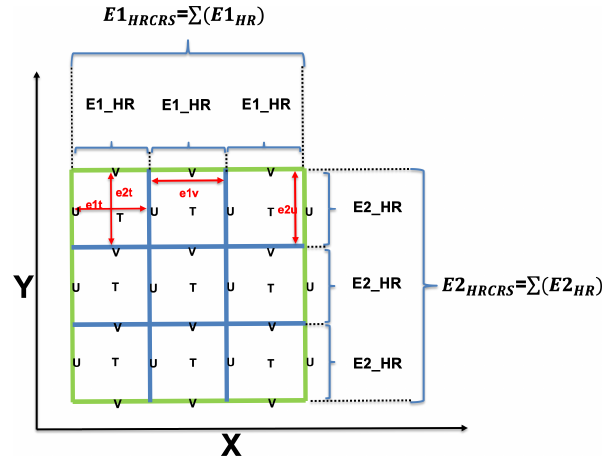
Figure 2. Horizontal dimensions of high-resolution ocean HR grid cells (blue lines, red arrows, with names following NEMO nomen- clature) and the corresponding coarsened biogeochemical HRCRS grid cell (green lines).